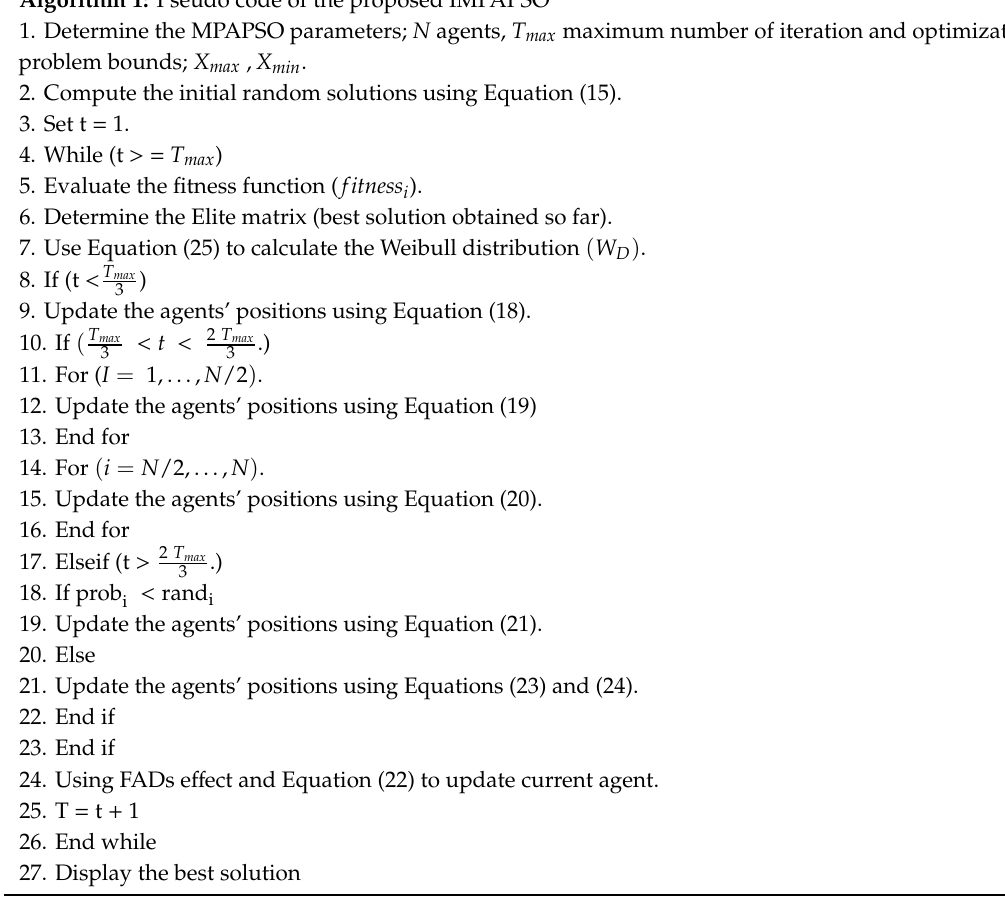
Algorithm 1: Pseudo code of the proposed